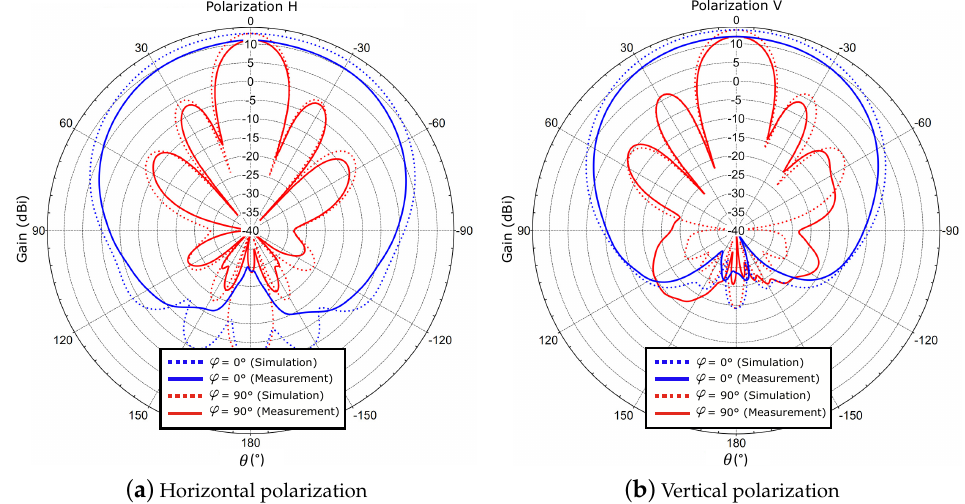
Figure 8. Comparison simulation and measurement @ f 0 = 1.325 GHz: co-polar patterns. Normal array. Uniform amplitude and phase